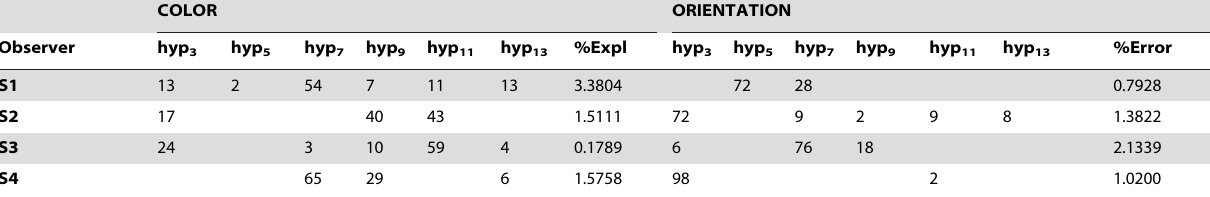
A. The combinations of theoretical hypergeometric and binomial models providing the best fit to the empirical psychometric functions ( N